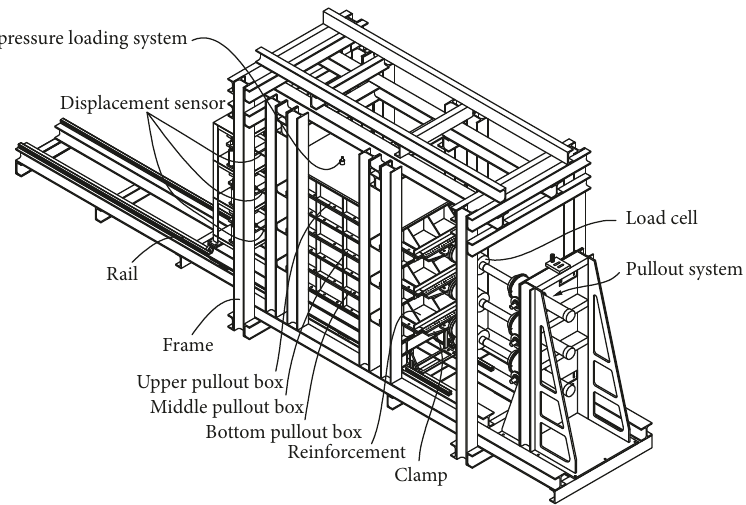
Figure 2: Detailed drawing of the multilayer pullout test apparatus [21].